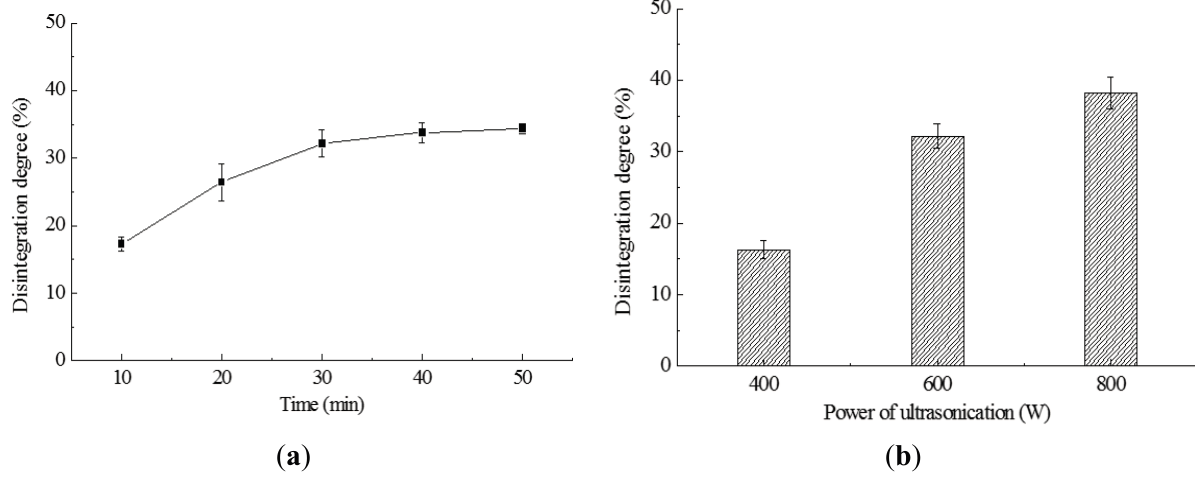
Figure 1. Effects of ultrasonic treatments on the disruption degree. ( a ) The ultrasonication power was 600 W; ( b ) the ultrasonic treating time was 30 min.